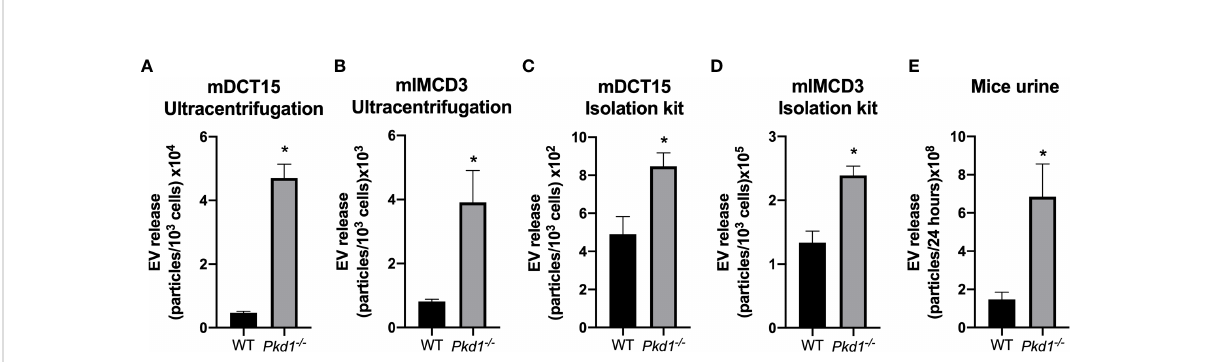
FIGURE 2 Increase in EV release in Pkd1 -/- models in vitro and in vivo . The concentration of EVs was analyzed by NTA in preparations obtained by ultracentrifugation from mDCT15 (A) and mIMCD3 cells (B) and by precipitation with the Total Exosome Isolation Reagent (from cell culture medium) from mDCT15 (C) and mIMCD3 cells (D) . The particle concentration was normalized to the total cell count. Data are shown as mean ± SEM (n = 3). Urinary EVs in samples from Pkd1 -/- and wild type (WT) mice were isolated with the Total Exosome Isolation Reagent (from urine) and analyzed by NTA. Data are shown as mean ± SEM (n = 8 for WT mice and n = 5 for Pkd1 -/- mice) (E) . * indicates statistical difference from WT (p <